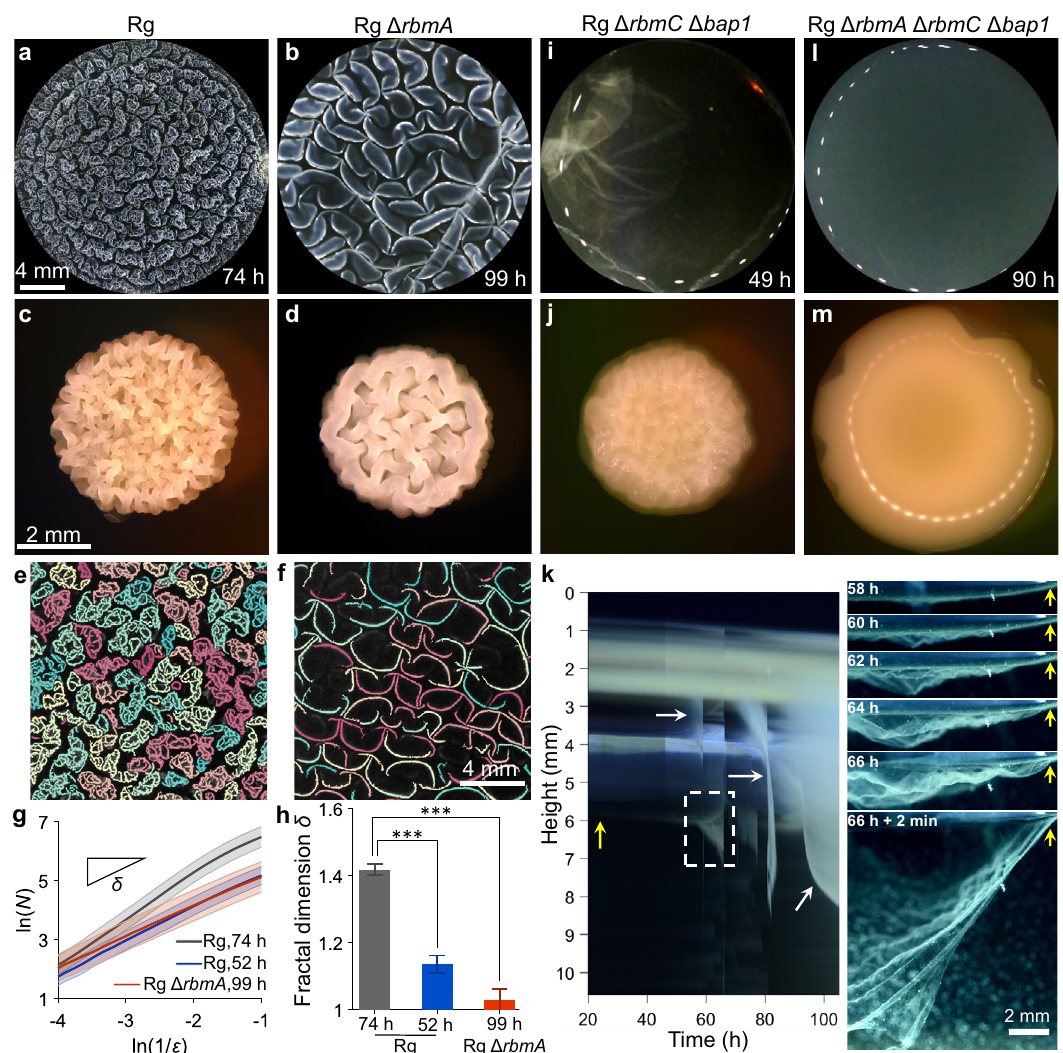
Fig. 2 | Matrix proteins drive fractal wrinkling and enable interfacial localiza- tion during V. cholerae pellicle morphogenesis.a , b , i , l Pelliclemorphologiesat theliquid – liquidinterface and c , d , j , m morphologiesonsolid agarsurfacesofthe indicatedstrains.Thepellicleswereimagedatthedesignatedtimepointsandtheir morphologiesonsolidagarsurfaceswereimagedat51hofgrowth. e , f Segmented pellicle wrinkle features for e the Rg strain during the fractal wrinkling regime at 74h and f the Rg Δ rbmA strain at 99h, time points showing the fully matured morphologies. The different colors denote disconnected wrinkle features. g The Hausdorff dimensions obtained from the scaling exponent of the box count N versustheboxlengthscale ε fromtheimagesoftheRgstrainattheridgeinstability stage(52h),fractalstage(74h,asin e )andtheRg Δ rbmA strainatlongtimes(99h,